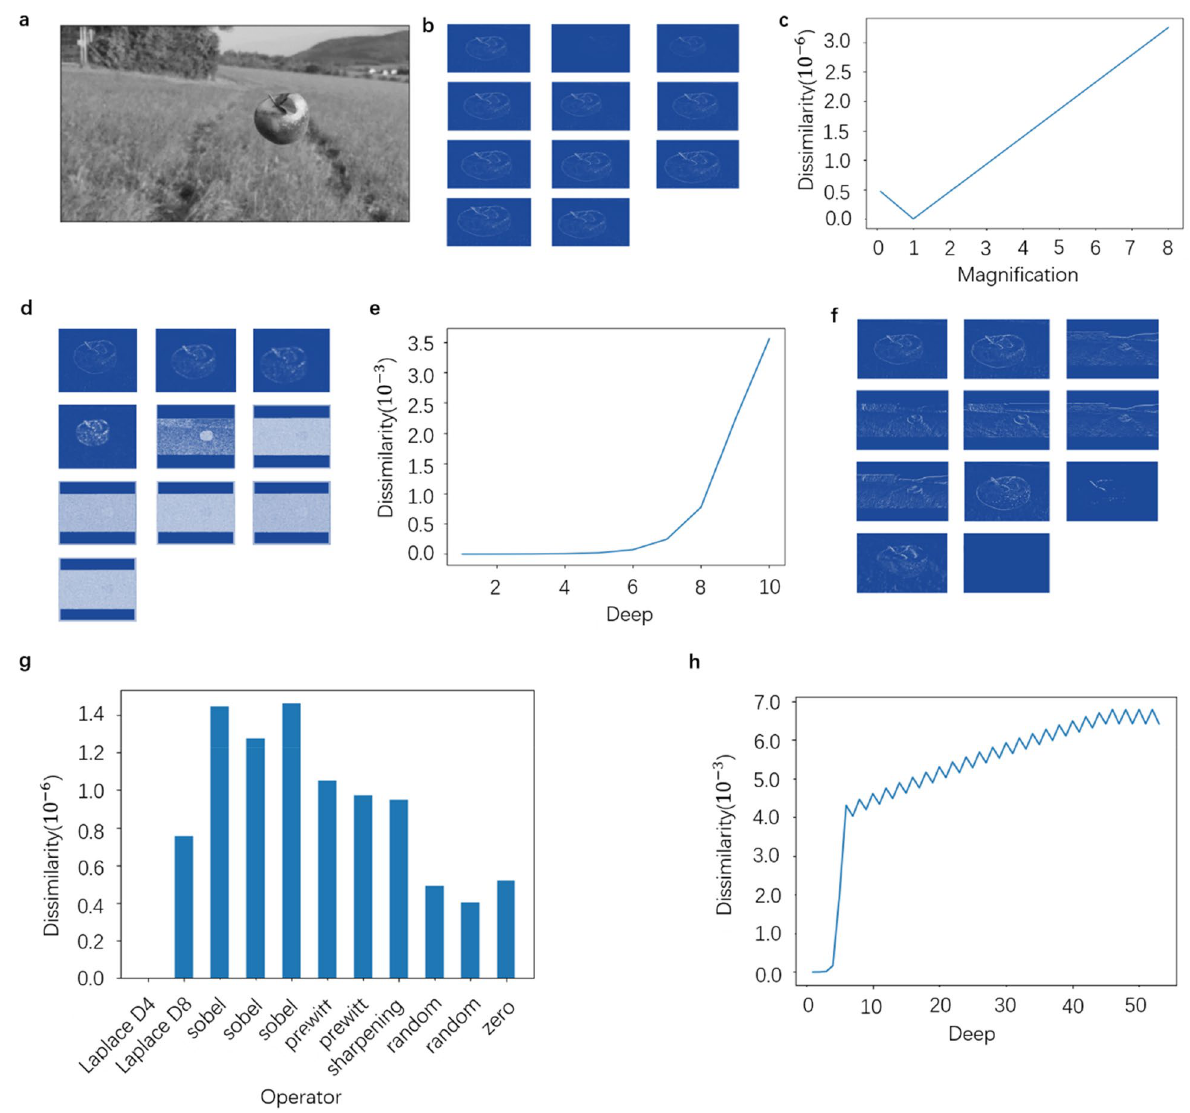
Figure 4. Similarity analysis of feature map. ( a ) Original image for feature extraction. ( b ) Feature maps of LaplaceD4 operator at different magnifications (from 0.1 to 8). ( c ) Variation curve of dissimilarity with different magnification. ( d ) Feature maps of LaplaceD4 operator at different depths (from 1 to 10). ( e ) Variation curve of dissimilarity with different depths. ( f ) Feature maps obtained by different convolution operators. ( g ) Dissimilarity of feature maps obtained by different operators relative to Laplace D4 operator. ( h ) At the end of the dissimilarity calculation, divide the depth value of the current feature map, and use 53 times Laplace D4 to simulate the 53-layers convolution network to obtain the curve of dissimilarity with depth. It can be seen that with the increase of depth, the final results after processing tend to